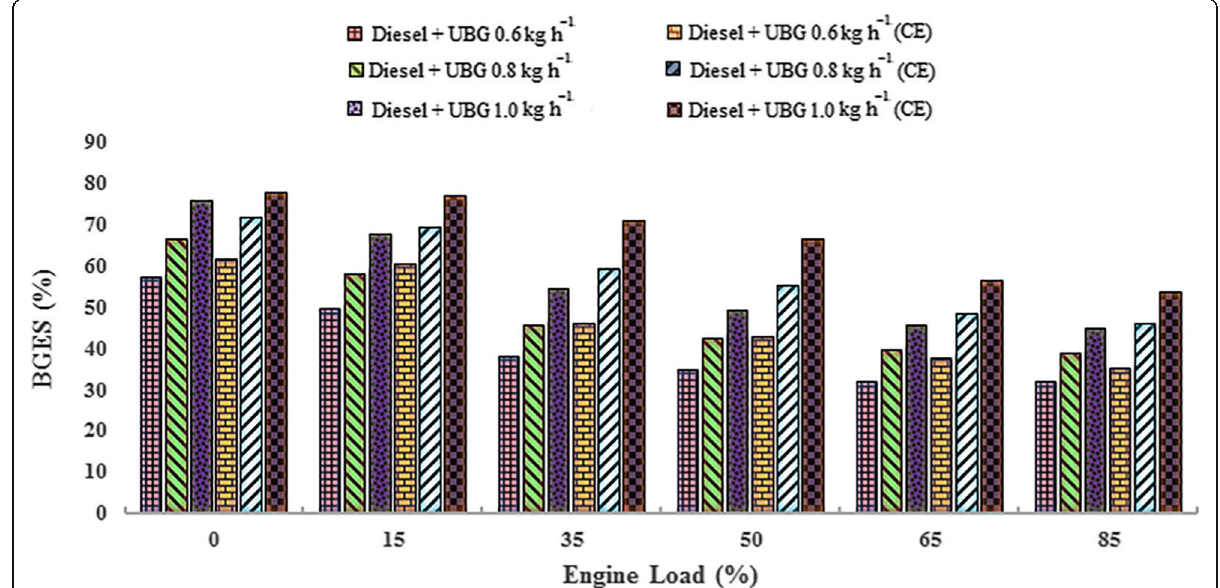
Fig. 5 Variation of BGES with engine